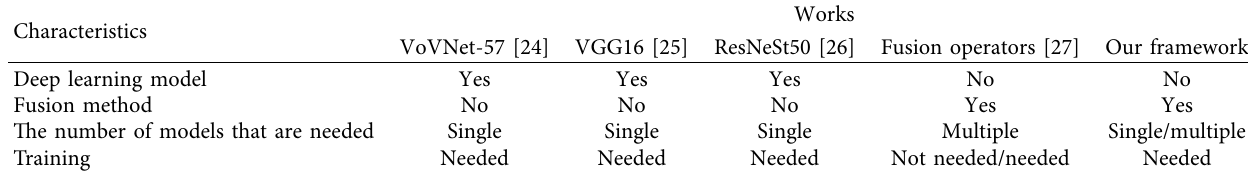
Table 1: Categorizing the reviewed works and ours along with their main distinctive characteristics.